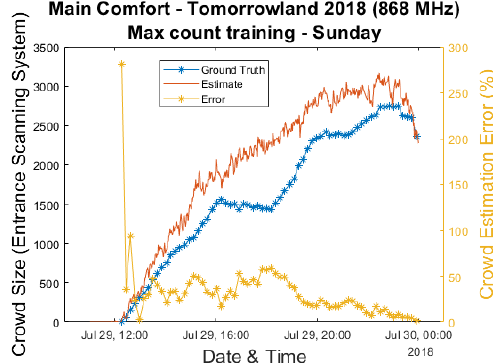
Figure 12. A graph showing the evolution of the crowd estimate of the passive RF based system versus the estimate of the scanning system and the resulting error percentage between the two for the final festival